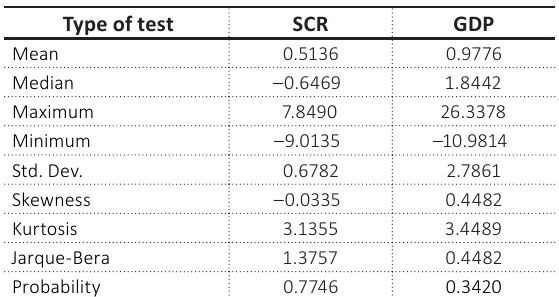
Table 5. VAR residual normality test for